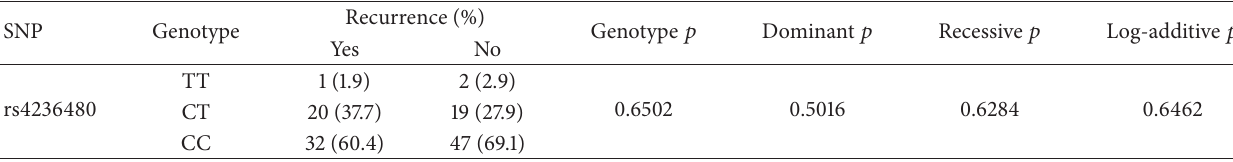
Table 3: Association analysis of TRPV5 rs4236480 and kidney stone